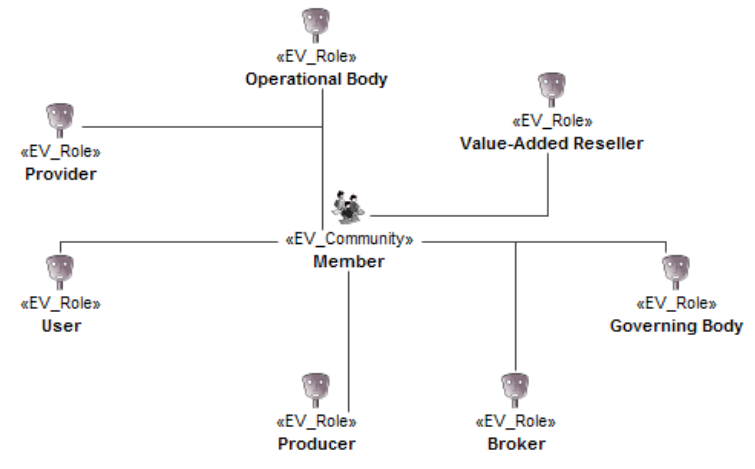
Figure 3. Seven main possible actor roles of an SDI. Source: